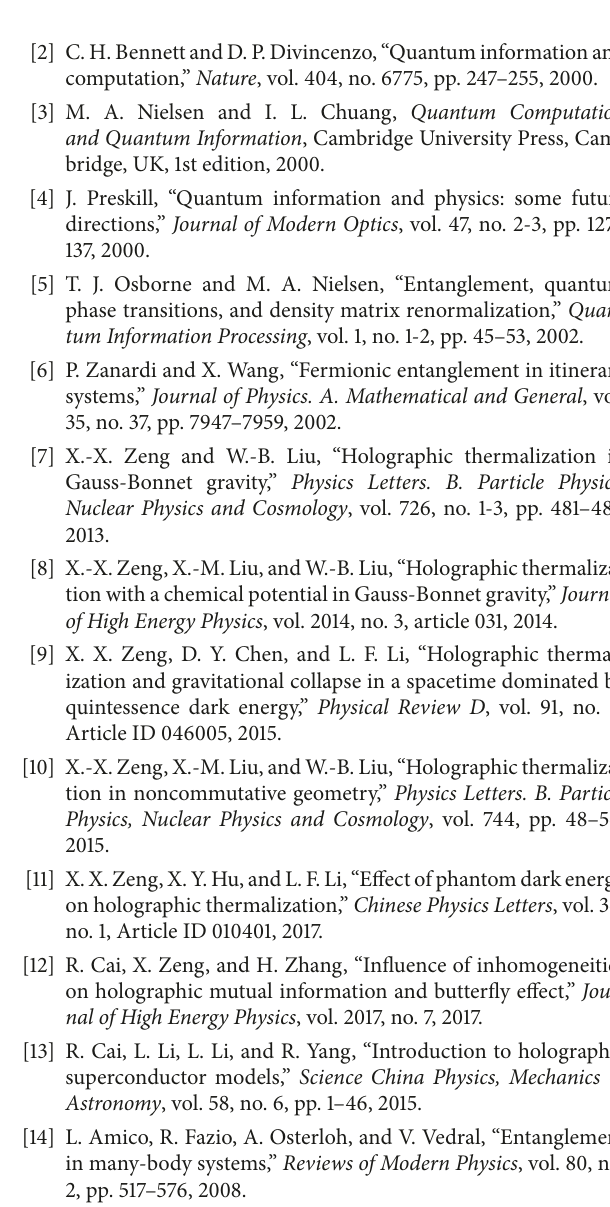
Figure 11: The figure shows log |𝑇 − 𝑇 𝑐 | versus log |𝛿𝑆 − 𝛿𝑆 𝑐 | for 𝛾 = −1 . Here 𝜆 = 2.4 , 𝑄 = 𝑄 𝑐 , where 𝜑 0 = 0.10 in (a) and 𝜑 0 = 0.16 in (b).